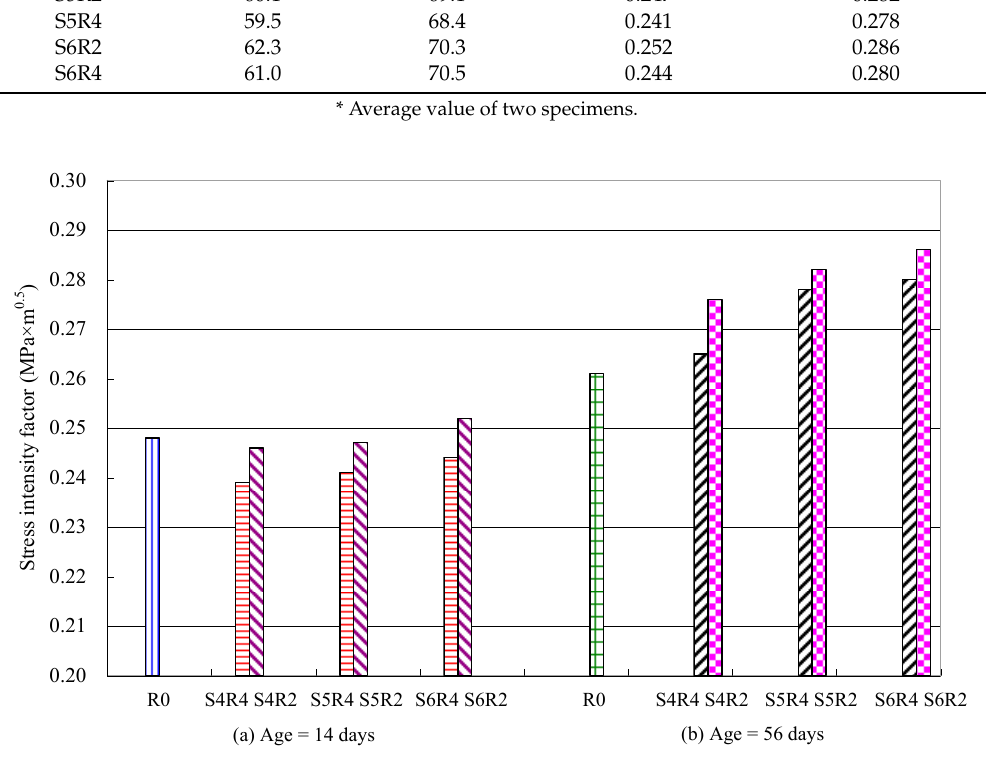
Figure 7. The stress intensity factor for concretes with various fineness levels and replacement ratios of slag at the ages of 14 days and 56 days.